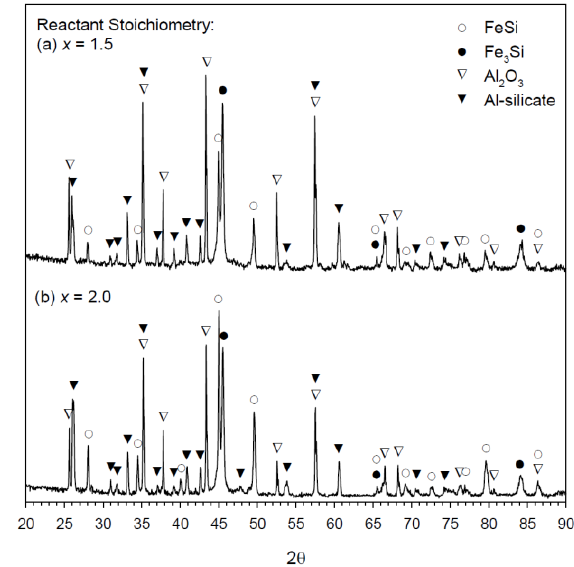
Figure 5. XRD patterns of Fe 3 Si/FeSi-Al 2 O 3 composites synthesized from Reaction (1) with ( a ) x = 1.5 and ( b ) x = 2.0.